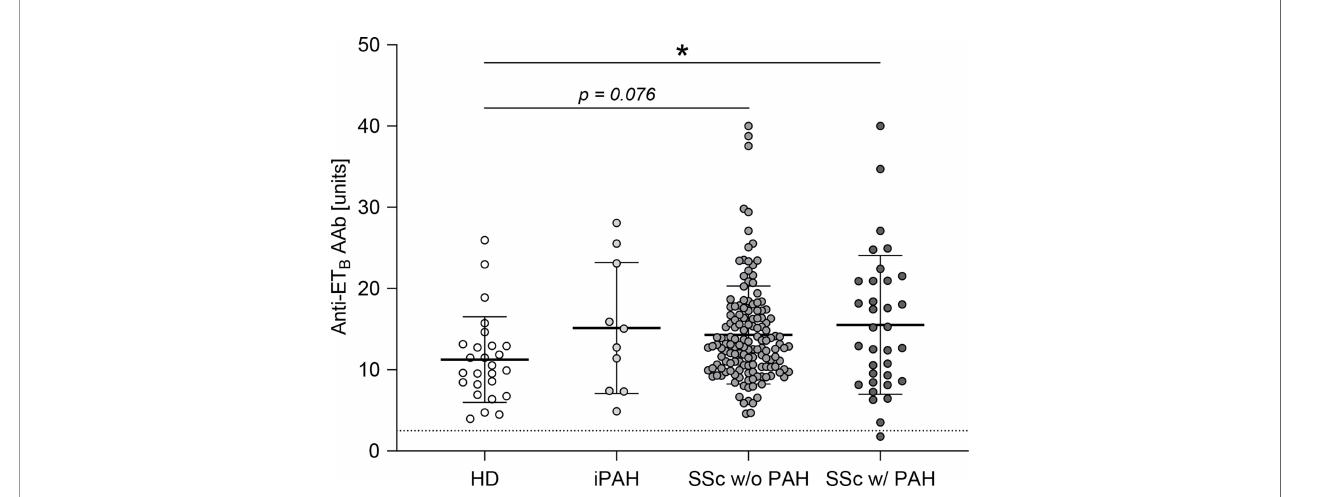
FIGURE 1 | Anti-ET B autoantibody serum levels were elevated in patients with PAH secondary to SSc. Serum levels of anti-endothelin B receptor (ET B ) autoantibodies (AAb) were quanti fi ed in healthy donors (HD), patients with idiopathic pulmonary arterial hypertension (iPAH), and systemic sclerosis (SSc) patients (+/- interstitial lung disease) with or without PAH. Data are expressed as single values with mean ± SD; N = 26 (HD) or N = 10 (iPAH) or N = 143 (SSc w/o PAH) or N = 34 (SSc w/PAH). The dotted line indicates the lower detection limit of the ELISA. * p < 0.05 (one-way ANOVA and Dunnett ’ s multiple comparisons